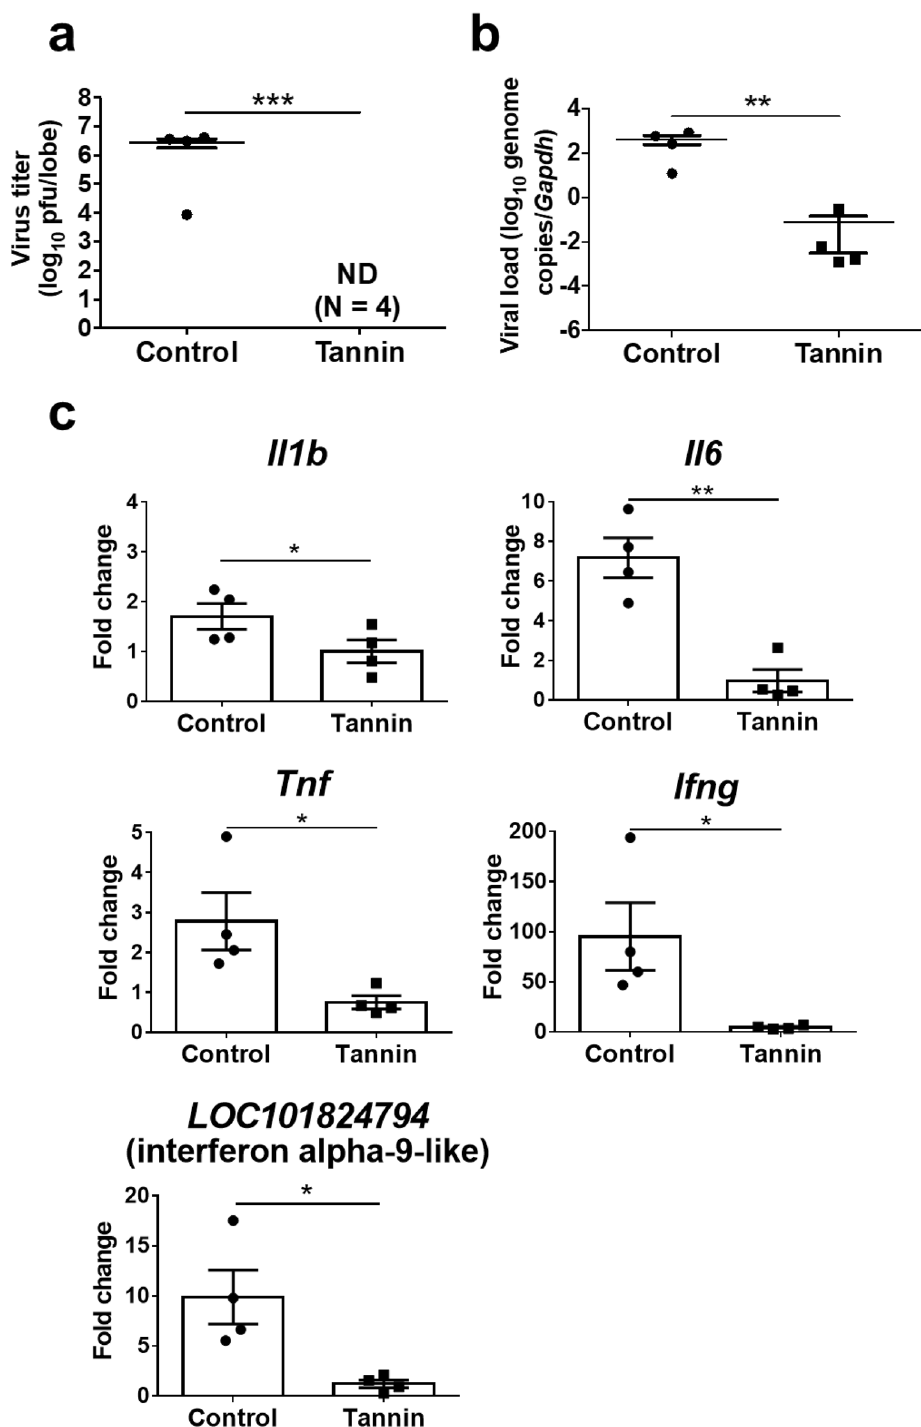
Figure 5. Effect of pre-administration of persimmon-derived tannin on virus titers, viral load, and inflammatory-related gene expression in the lung of contact hamsters cohoused with a virus-inoculated donor. ( a ) Virus titers were measured by plaque assay. The uppermost lobe of the right lung was used and the plaque- forming units (pfu) per lobe were calculated. ( b ) Viral load was measured by quantitative PCR. ( c ) Expressions of Il1b , Il6 , Tnf , Ifng , and LOC101824794 (interferon alpha-9-like) were measured by quantitative PCR. RNA extracted from the right lung was used and normalized to Gapdh expression. Data are shown as the mean ± SEM (control group; n = 4, tannin group, n = 4). ND, not detected. *p < 0.05, **p < 0.01, ***p <